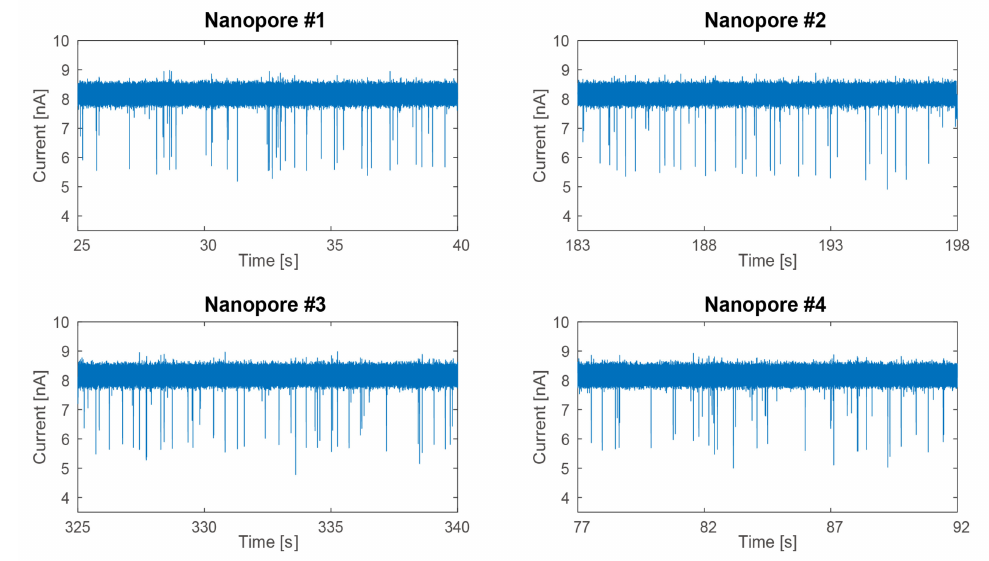
Figure 6. Observed DNA translocations with an average current variation of 1.6